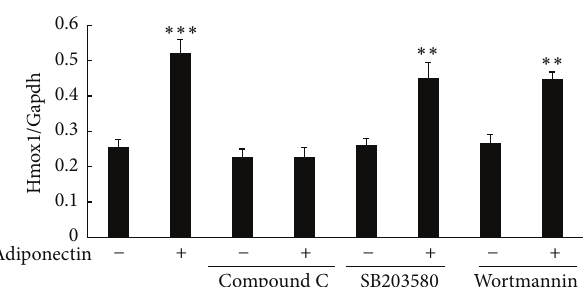
Figure 5: Effect of kinase inhibitors on adiponectin-induced HO-1 mRNA expression in RAW 264 cells. Raw 264 cells were cultured as described in Figure 1 legend and were treated with adiponectin (10 𝜇 g/mL) for 18 h in the presence of DMSO (control), compound C (10 𝜇 M), wortmannin (1 𝜇 M), or SB203580 (10 𝜇 M). RNA was extracted, and expressions of Hmox1 (HO-1) and Gapdh mRNAs weremeasuredusingqRT-PCR.Theresultsareexpressedasmeans ± SE of three independent experiments ( ∗∗∗ 𝑝 < 0.001 and ∗∗ 𝑝 < 0.01 significance compared with control).